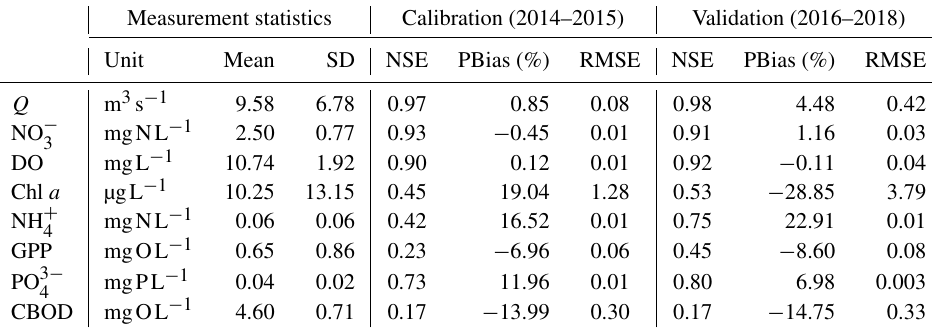
Table 3. Statistics of measurements and model evaluation criteria (NSE, RMSE, and PBias) of calibration and validation results at the STF station of the Lower Bode